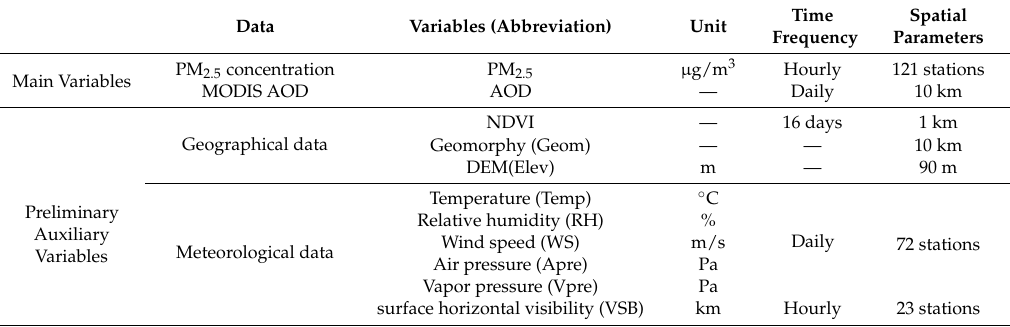
Table 2. Main parameters of all involved variables in GWR